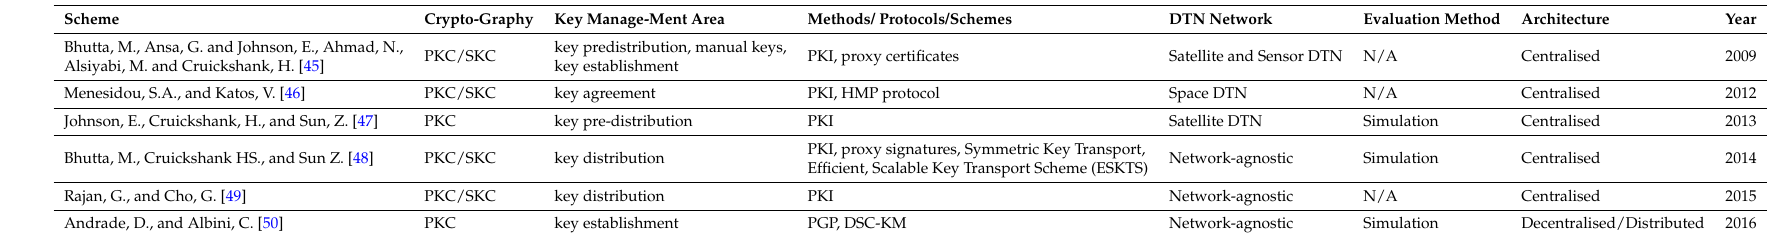
Table 3. Comparison of two-party PKI and PGP-based key establishment methods.